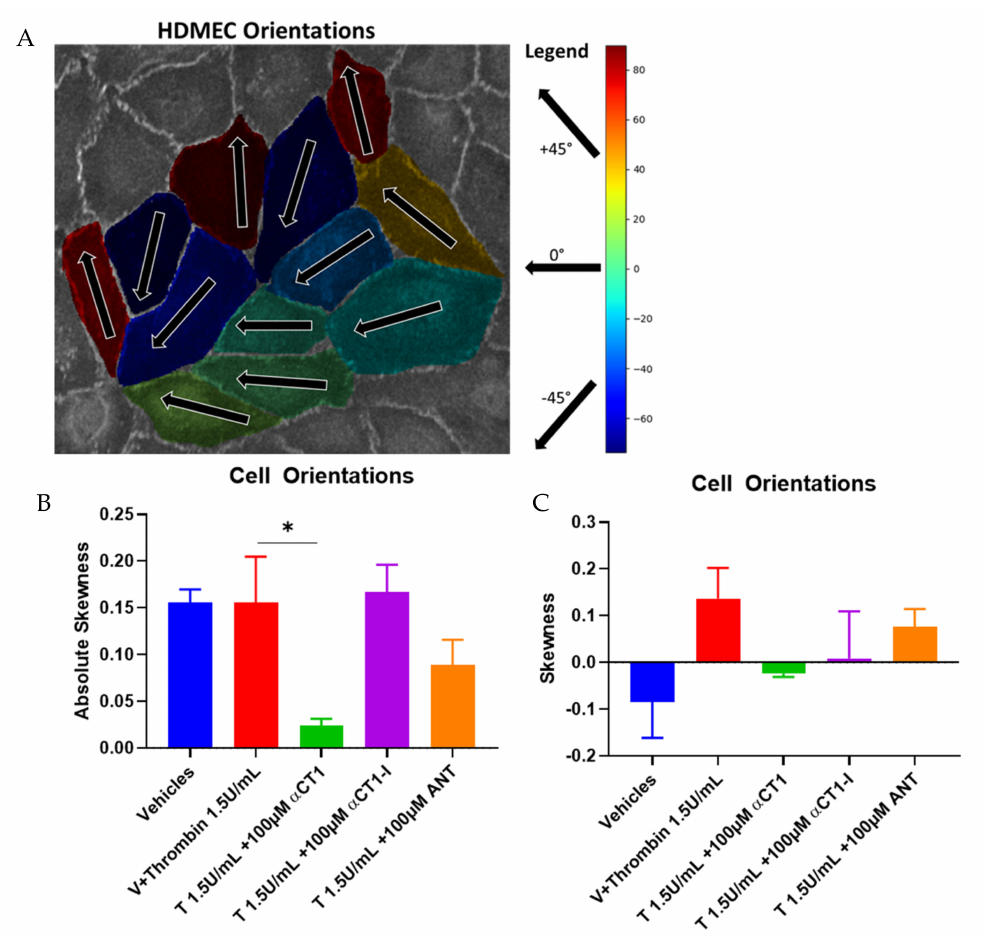
Figure 9. α CT1 alters distribution of cell orientations in HDMEC monolayers. ( A ) Representative diagram of cell angle designation across a HDMEC monolayer. ( B ) Absolute skewness measurements, calculated as the absolute value of g1 = the average value of z 3 , where z is the familiar z-score, z = ( x − x )/ σ , where x is the individual cell angle with respect to 0 ◦ angle reference axis. ( C ) Raw skewness values calculated as g1 above, no absolute value calculated, * p < 0.05 vs. Thrombin; N =